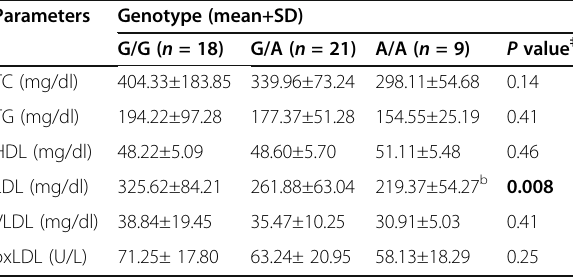
Table 7 Lipid profile and oxLDL response to atorvastatin treatment (40 mg/day) according to apolipoprotein B ( ApoB ) rs676210 polymorphism in the patients with